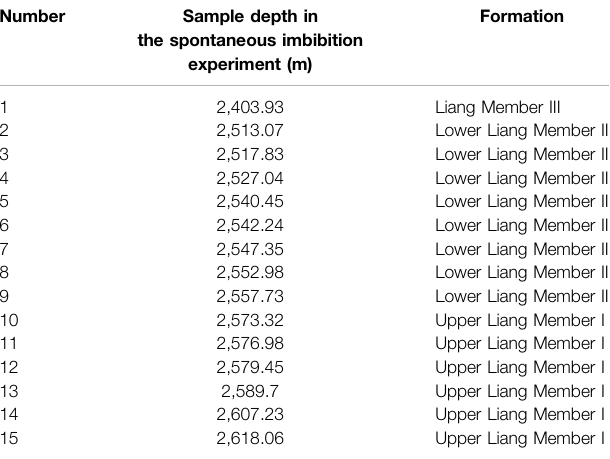
TABLE 1 | The depth and member of samples in the spontaneous imbibition experiment. Number Sample depth in the spontaneous